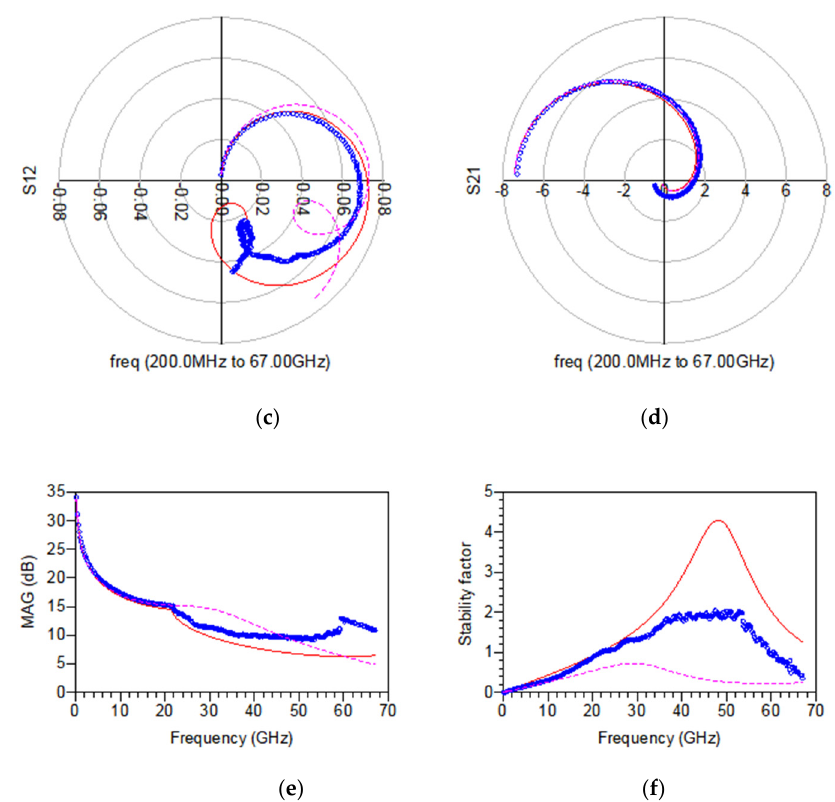
Figure 13. Comparison of ( a ) S11, ( b ) S22, ( c ) S12, ( d ) S22, ( e ) MSG/MAG, and ( f ) stability factor among the measurement (blue circle), the conventional model (pink dashed line), and the proposed model (red line) from 0.2 to 67 GHz under V ds = 16V, V gs = -1.0 V.